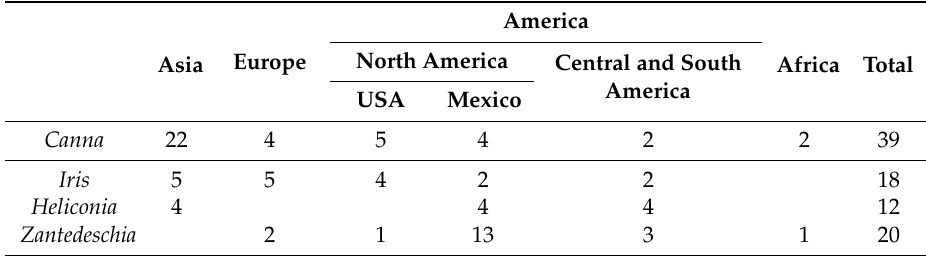
Table 2. Four most commonly genera plants used in CWs around the globe, identified during the 87 survey studies in 21 countries, grouped by continents.